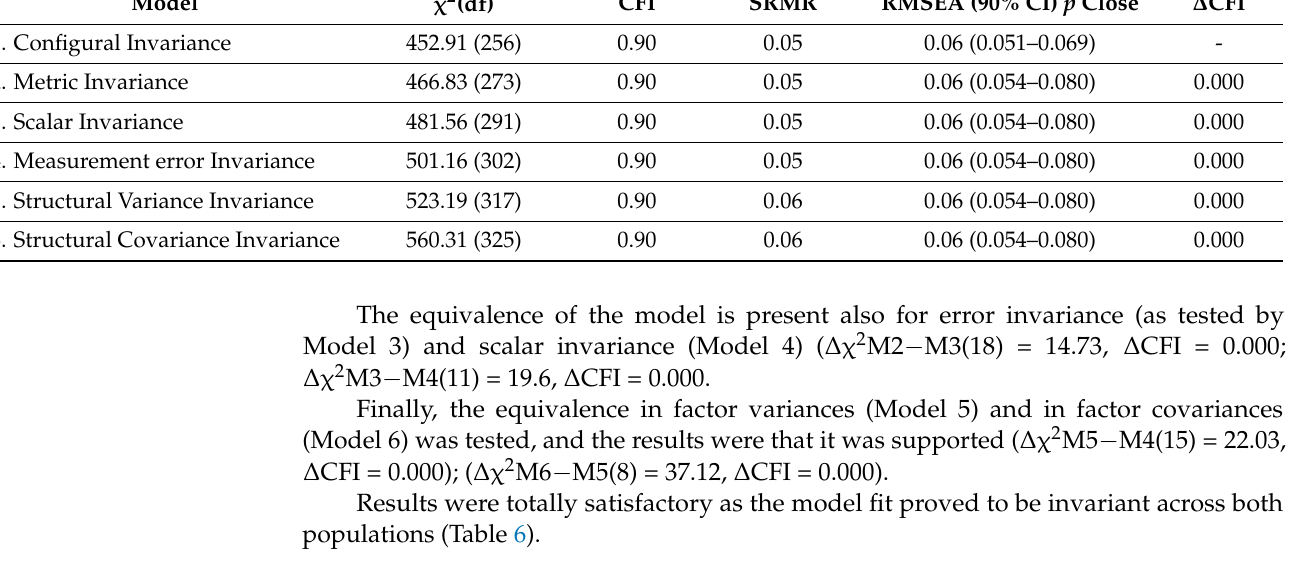
Table 6. Fit statistics for measurement invariance by experimental group and control group.